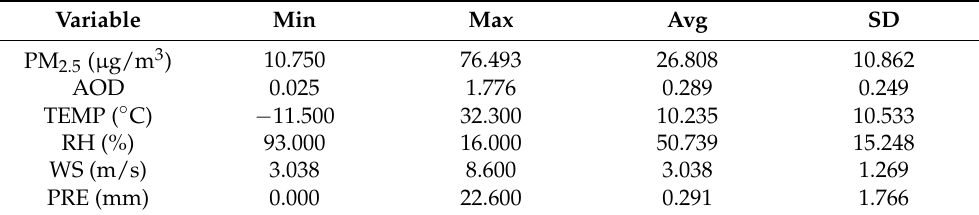
Table 2. Fusion data descriptive statistics.